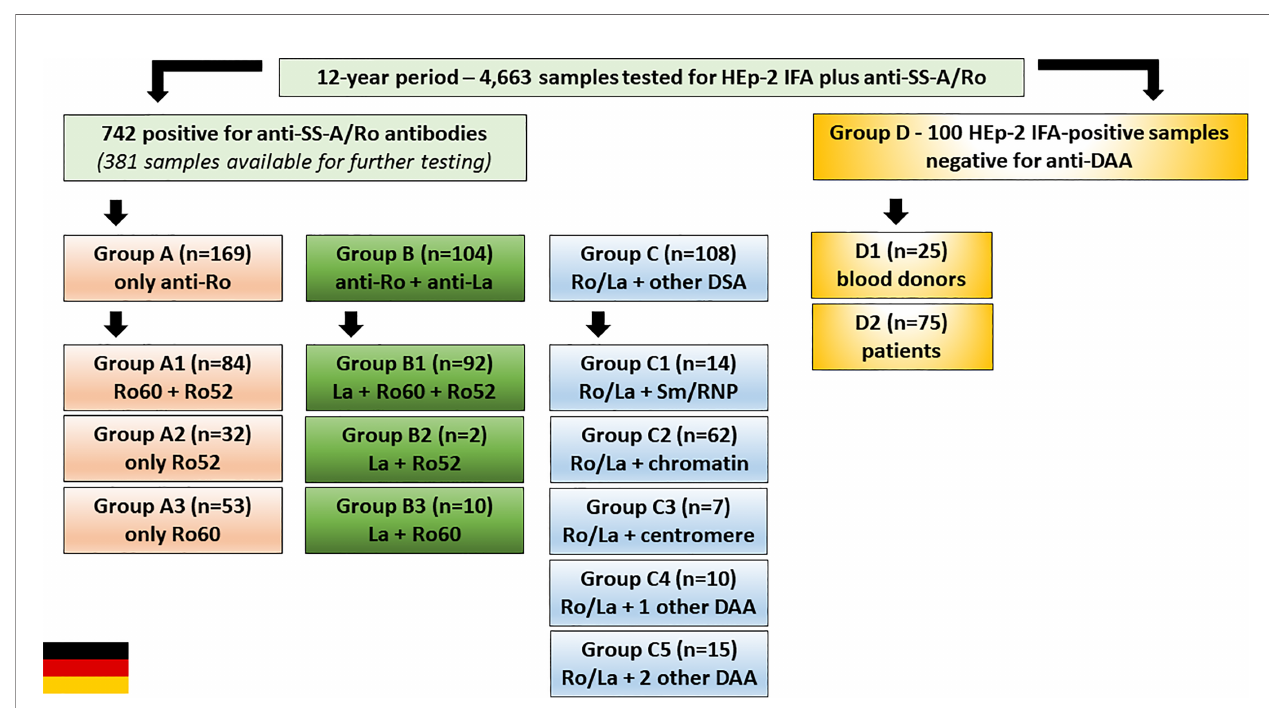
FIGURE 3 | Serum samples from theInstitute of Immunologyof the Technical University of Dresden, Germany, were classi fi ed into fourgroups. Group A: samples with antibodies to SS-A/Ro and noother disease-associated autoantibody (DAA) (dsDNA, nucleosome, Sm,U1-RNP, SS-B/La, Scl-70, Jo-1). GroupB:samples with antibodies to SS-A/Ro and SS-B/La, and no additional DAA. GroupC: samples with anti-SS-A/Ro antibodies (with orwithout anti-SS-B/La) and one or more additional DAA. Group D: samples with positive HEp-2 IFAresult and negative for anti-SS-A/Ro and other DAA. Each groupwas further strati fi ed as shown inthe